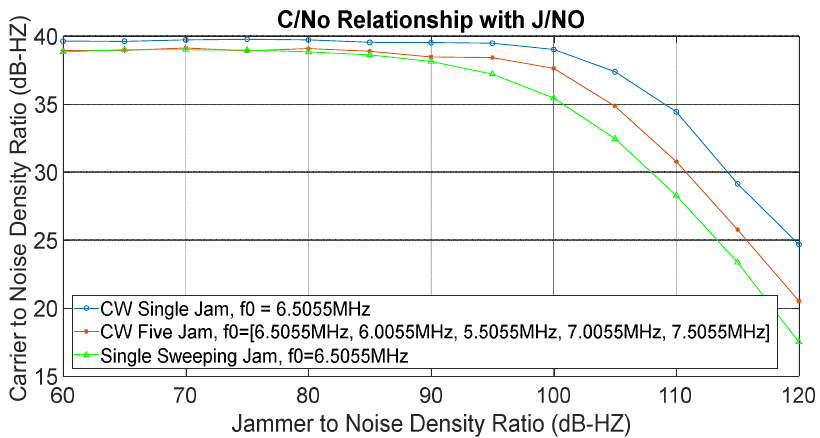
Figure 19. Averaged C/No degradation for one jammer (freqj = 6.5055 MHz), five jammers (freqj = 6.5055 to 7.5055 MHz), and the sweeping bandwidth jammer (freqj = 6.5055 MHz) with the applied filter .